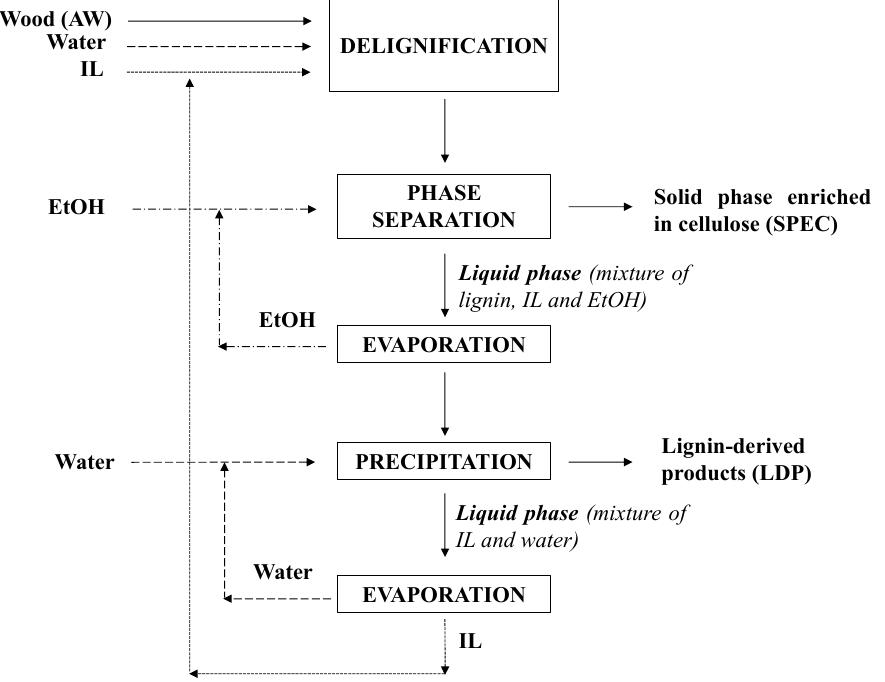
Figure 1. General scheme followed for lignin separation .